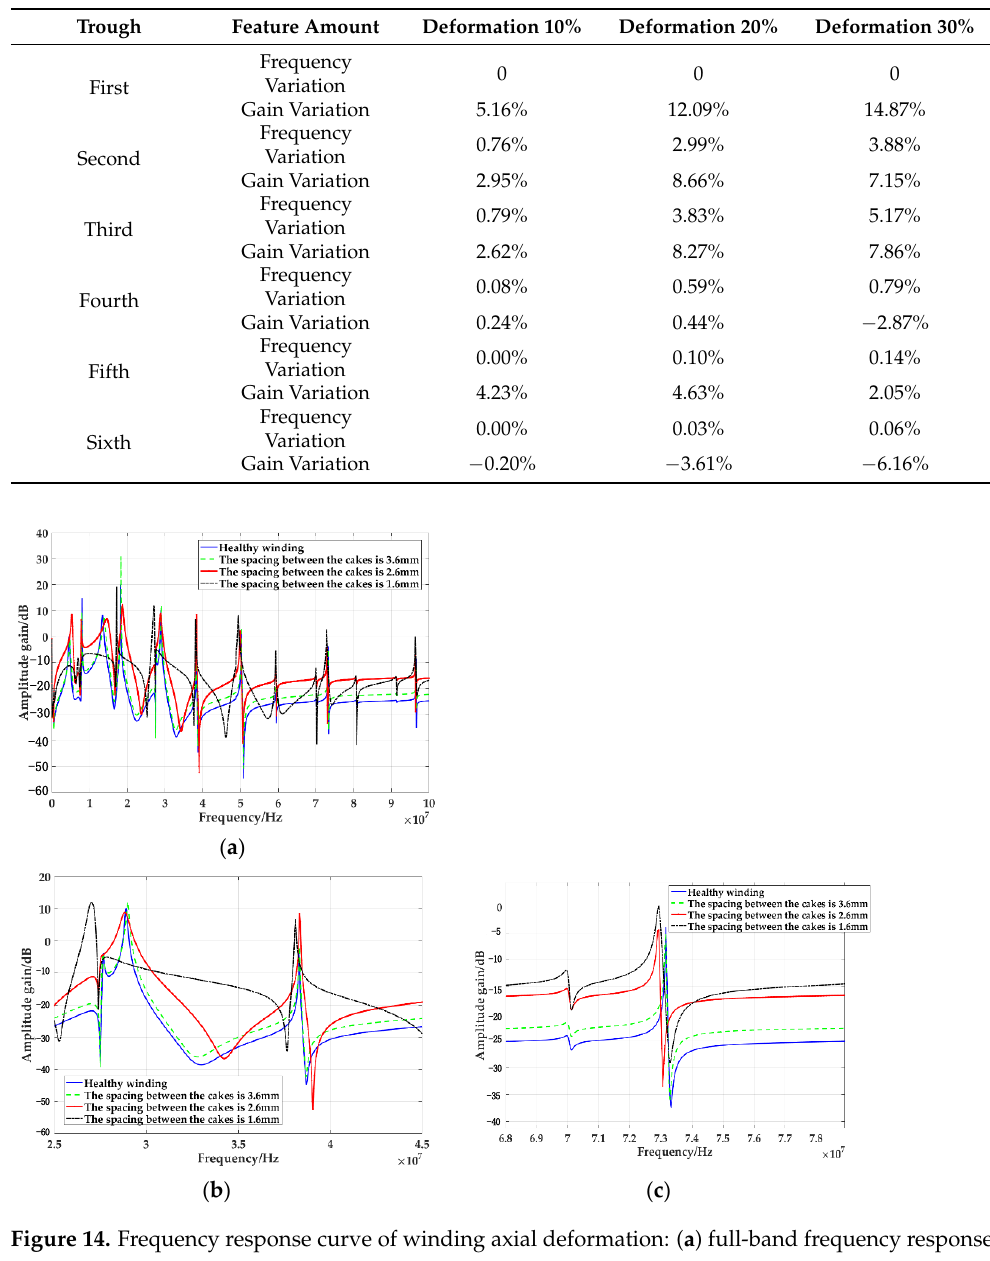
Table 12. Variation in valley frequency and amplitude gain.